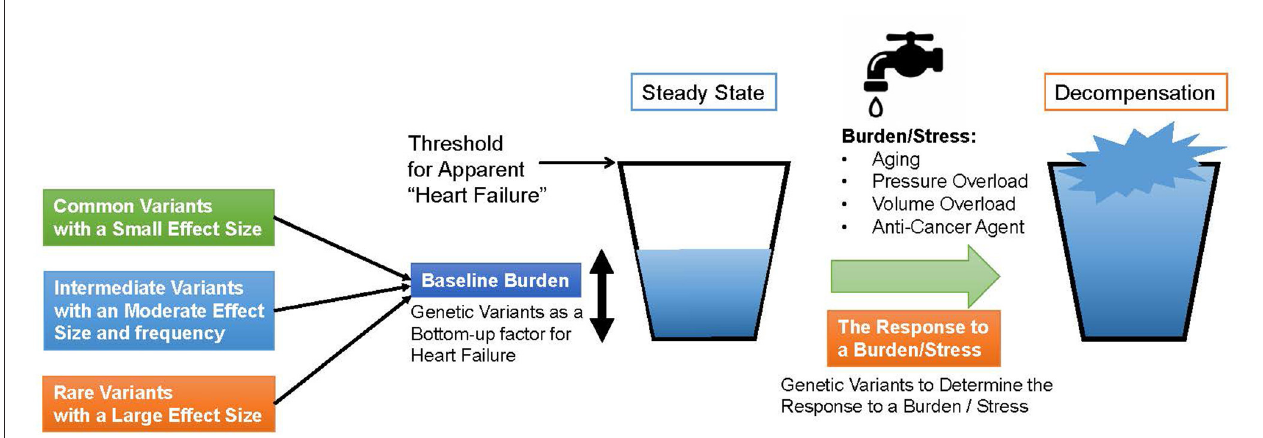
FIGURE 1 | A model for heart failure development. The horizontal line denotes a threshold for apparent heart failure. First, genetic Variants determine the baseline burden of the heart and serve a bottom-up factor for heart failure. If a patient has a cardiomyopathy-causing variant, the baseline burden itself may exceed the threshold. When the heart is subjected to a burden or a stress such as aging, pressure or volume overload and anti-cancer agent, the amount of the burden grows up and exceeds the threshold. In the process, genetic variants determine the response to the burden or the